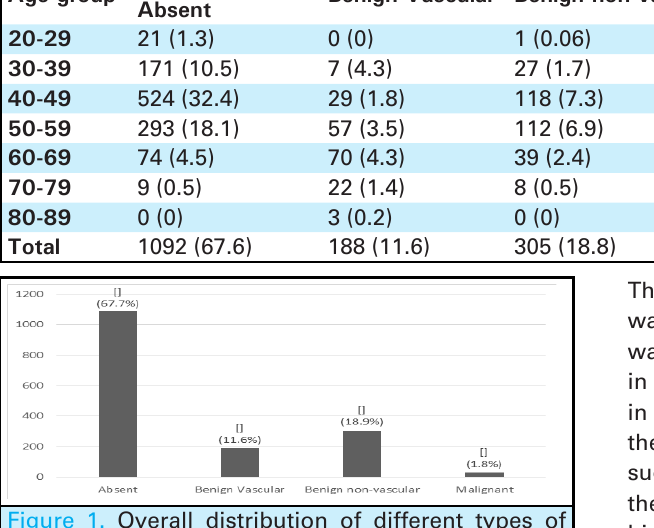
Table 1. Distribution of different types of calcifications in various age groups. Calcification Age group Absent